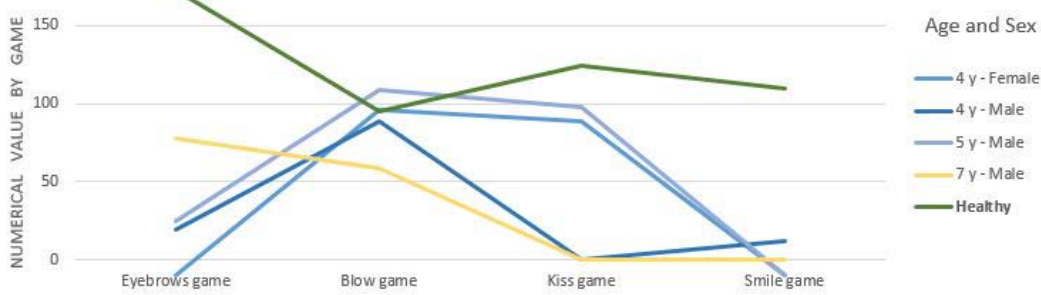
Figure 15. Comparative results obtained by children with CP (4–7 years) and healthy children.